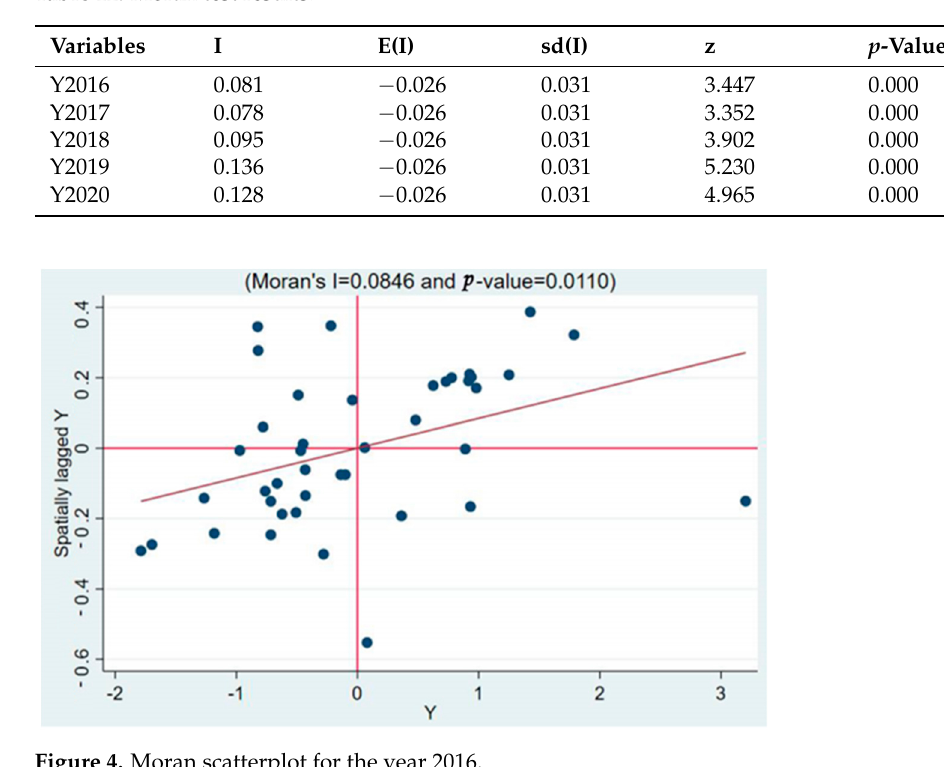
Figure 4. Moran scatterplot for the year